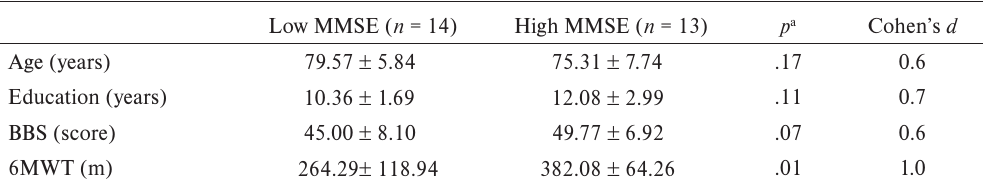
Demographic and clinical characteristics (M ± SD) for the participants with low (score 20–26) and high (score 27–30)